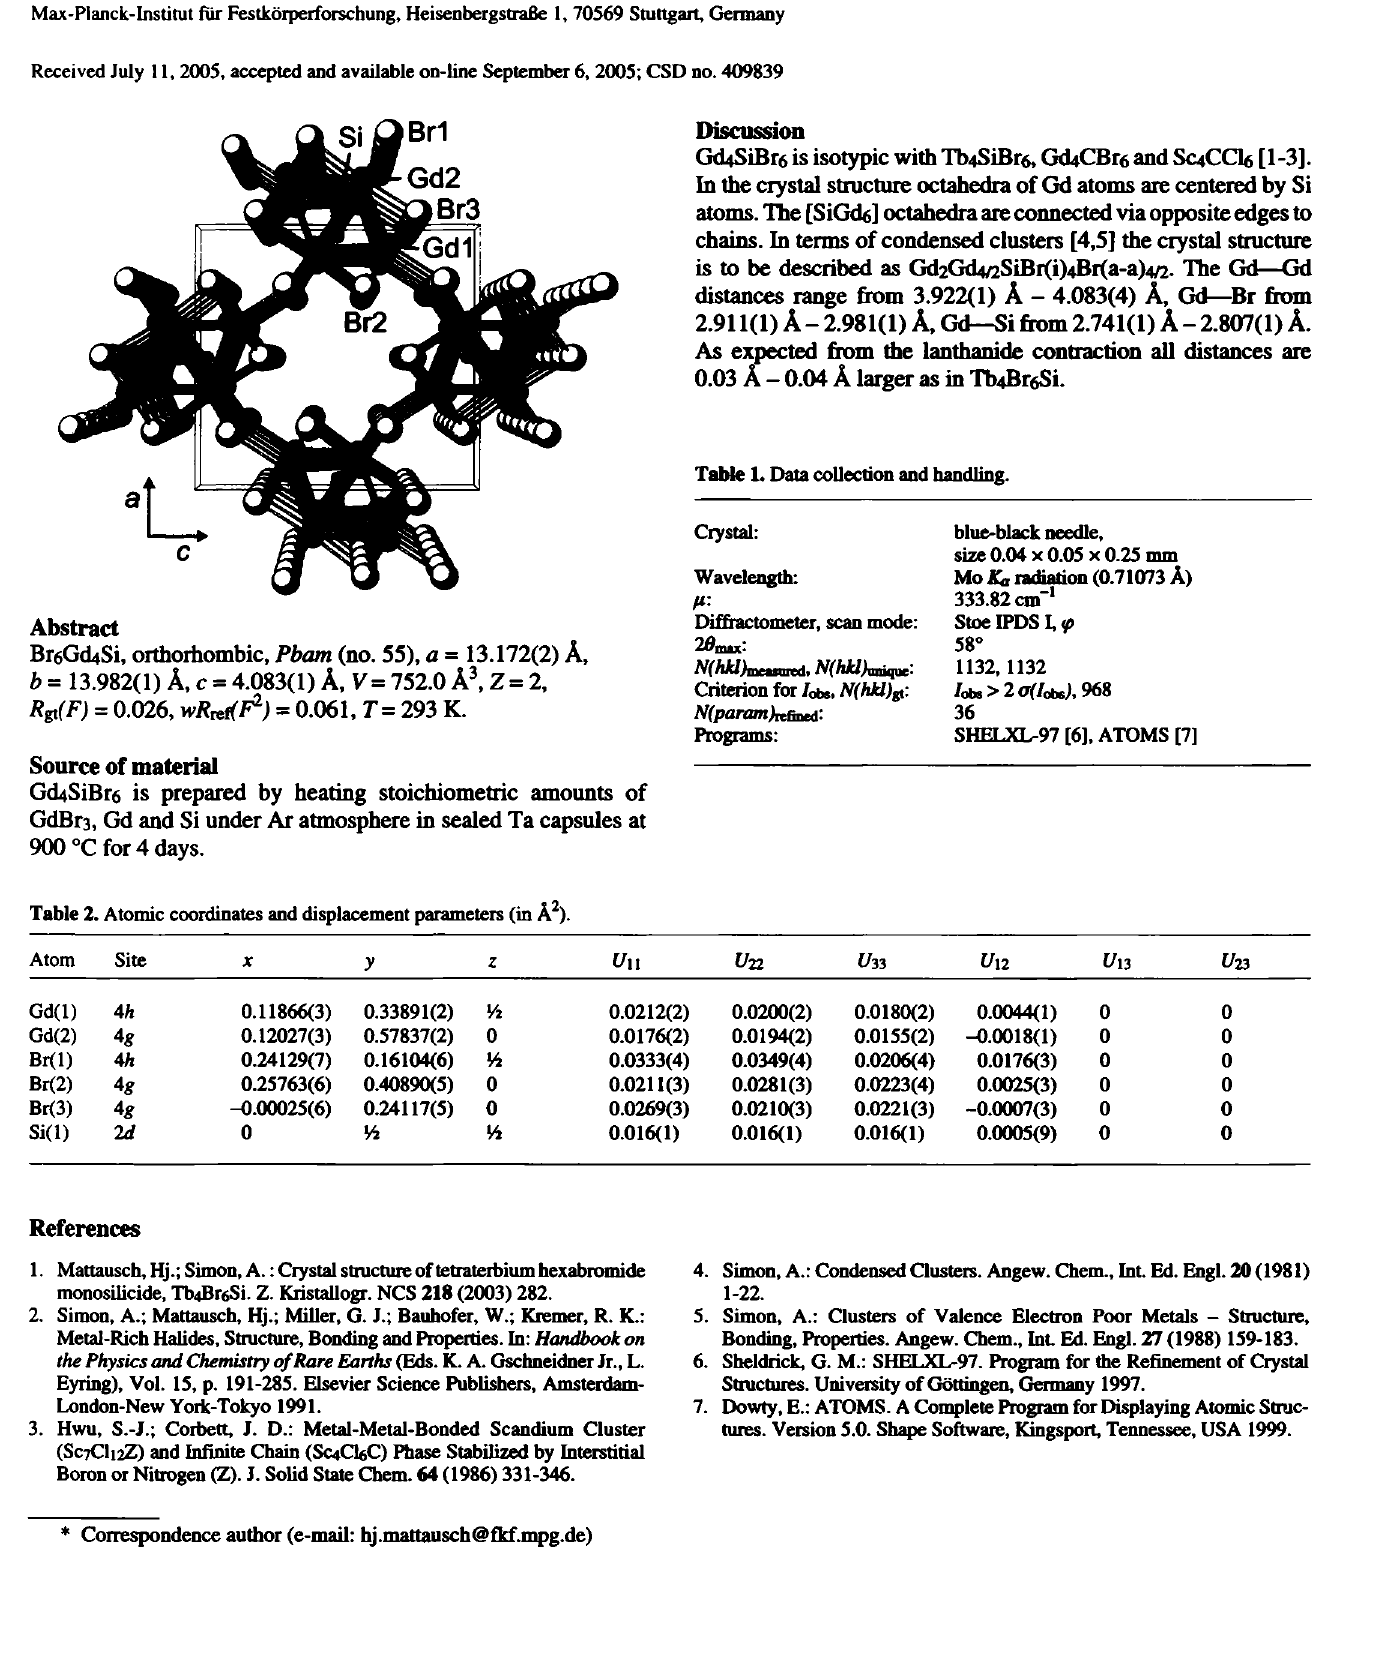
Table 1. Data collection and handling. Crystal: